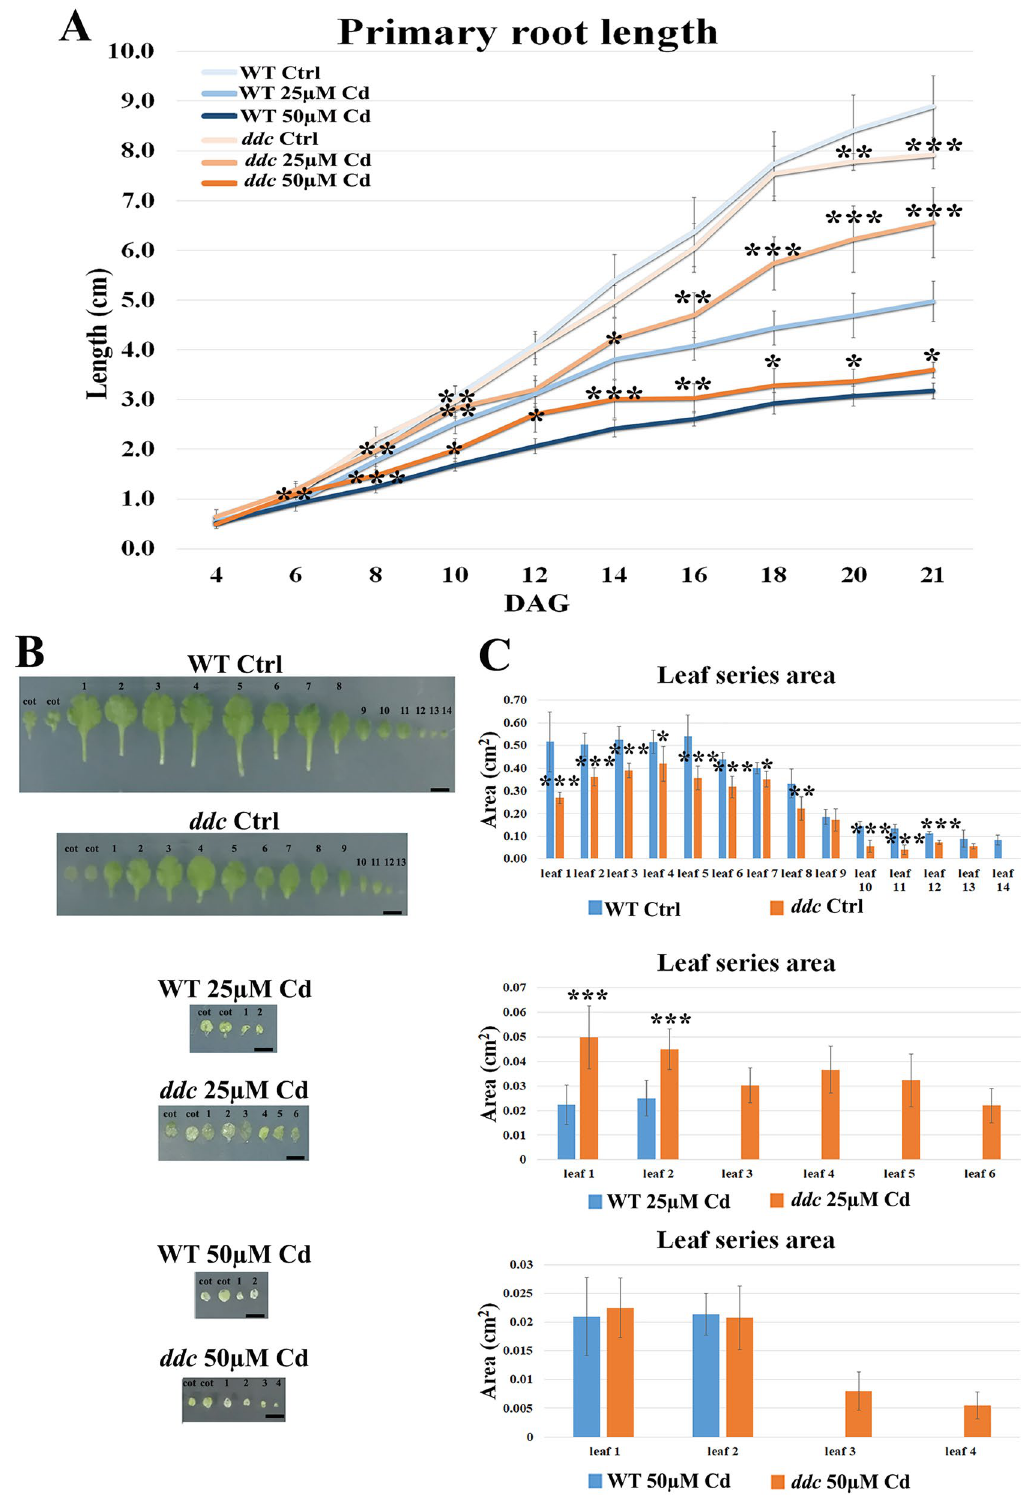
Figure 1. ( A ) Primary root length ( B ) Picture of rosette leaf series and ( C ) rosette leaf area (cm 2 ) of WT and ddc plants of A. thaliana , germinated and grown for 21 DAG in long day condition: (i) on growth medium added with 25 or 50 µM Cd; (ii) on growth medium without Cd as control (Ctrl). Root length was monitored up to 21 days after germination (DAG) every two days from germination. The results represent the mean value (± SD) of three independent biological replicates (n = 45). Asterisks indicate significant pairwise differences using Student’s t -test (*P ≤ 0.05; ** P ≤ 0.01; *** P ≤ 0.001) , performed between ddc vs WT subjected to the same treatment. Bars, 0.5